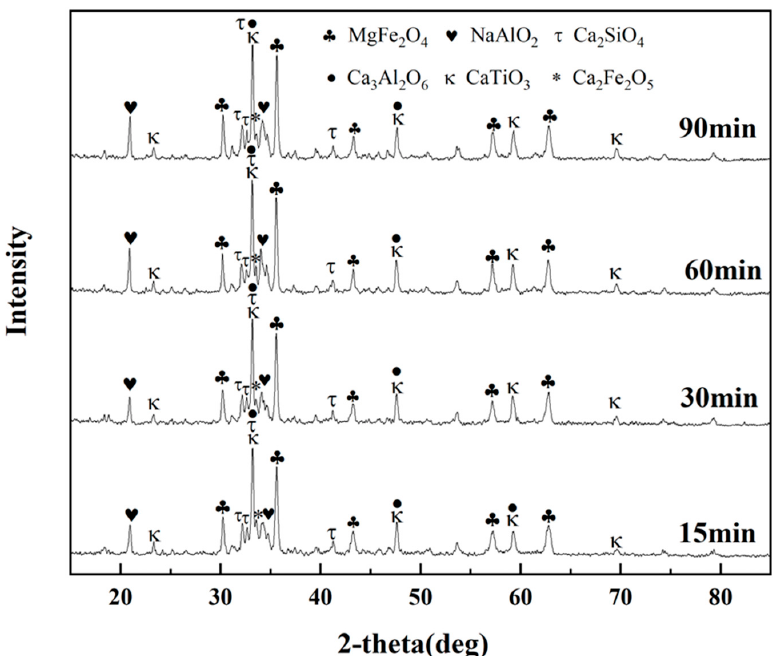
Figure 9. XRD pa tt erns of the sintered red mud at di ff erent times. Figure 9. XRD patterns of the sintered red mud at different times.